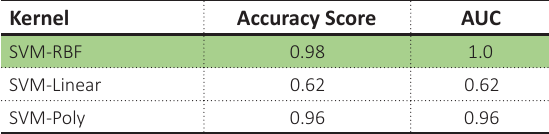
Table 6. The three error ratios of the three kernels Kernel